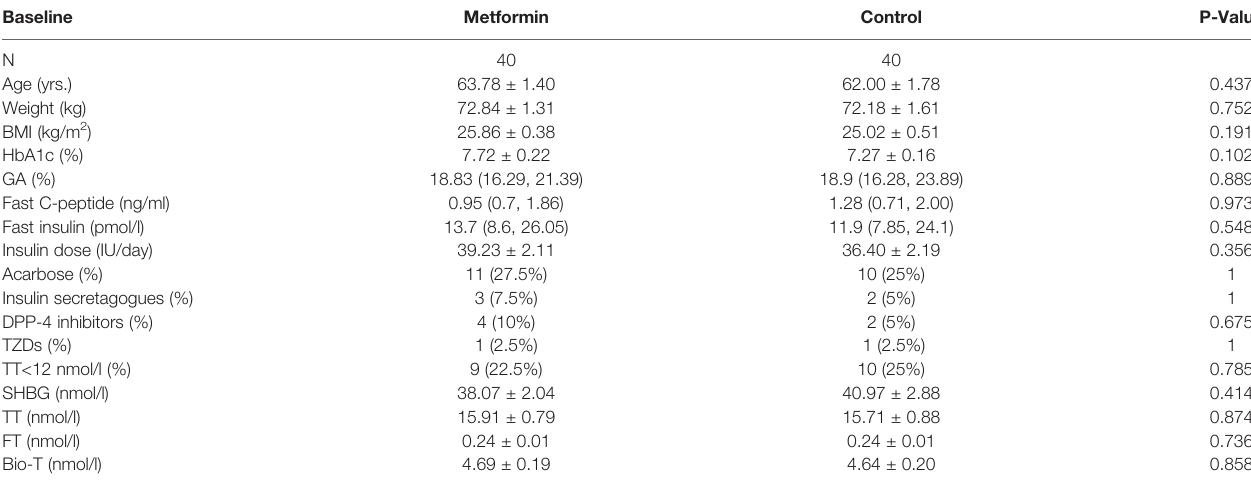
TABLE 1 | Baseline clinical and laboratory characteristics of the study participants. Baseline